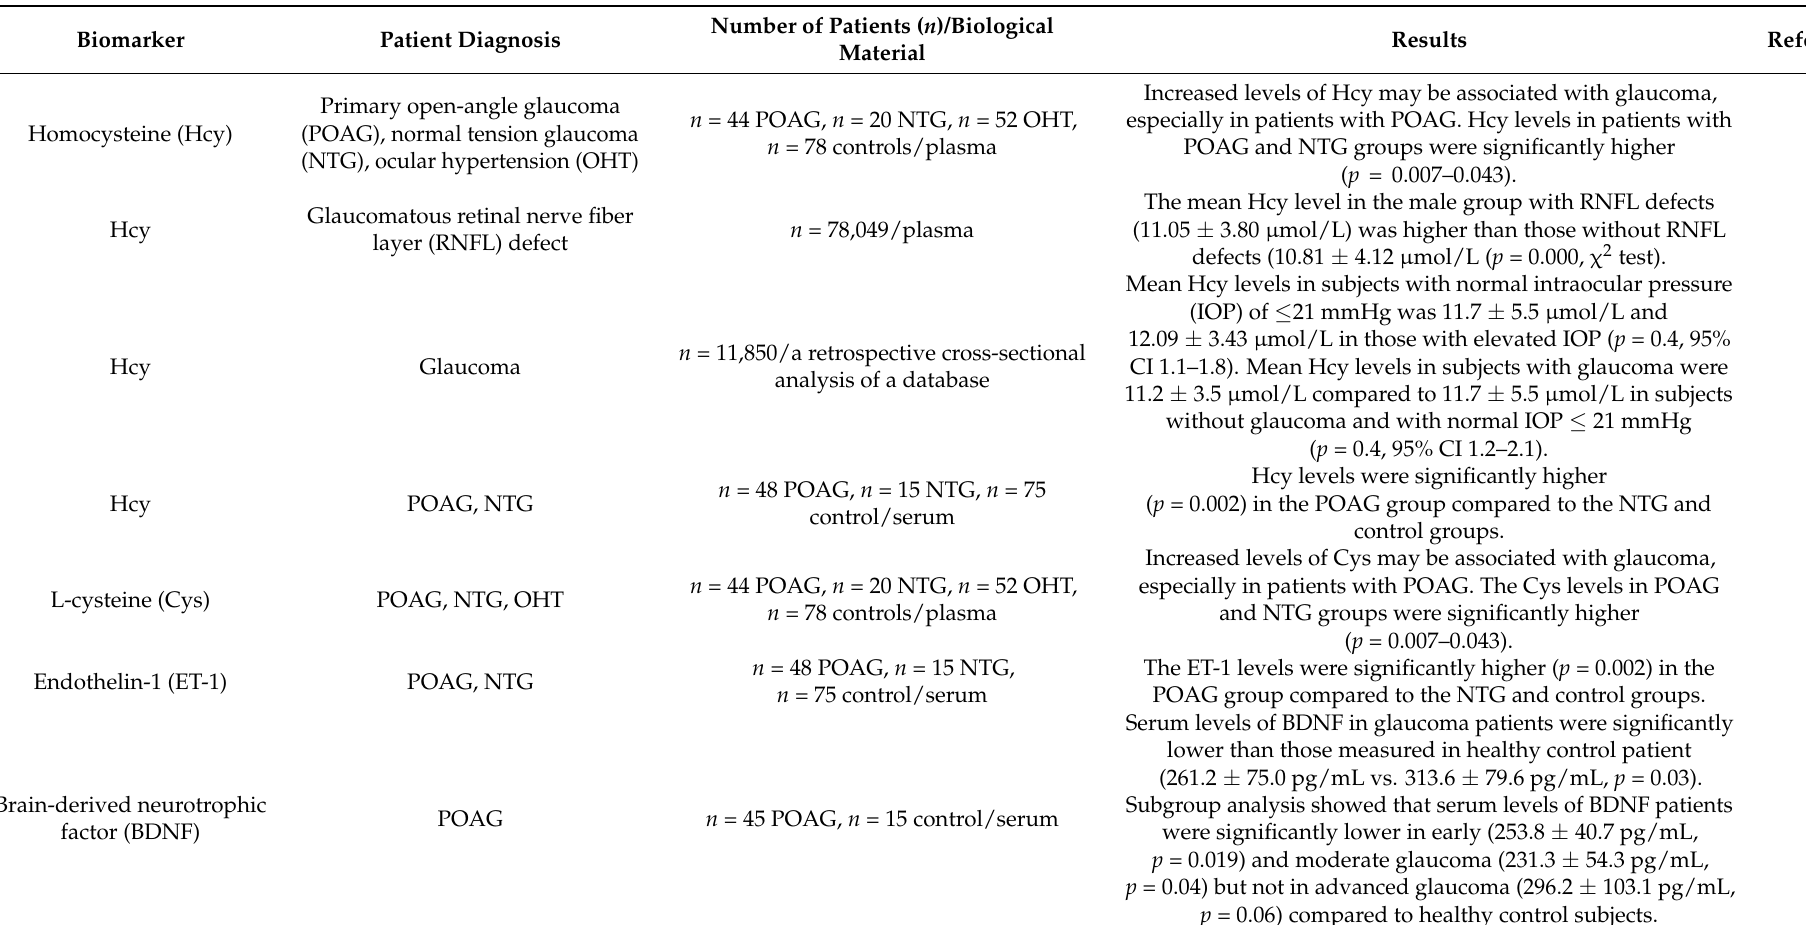
Table 1. Proteins evaluated as potential biomarkers in